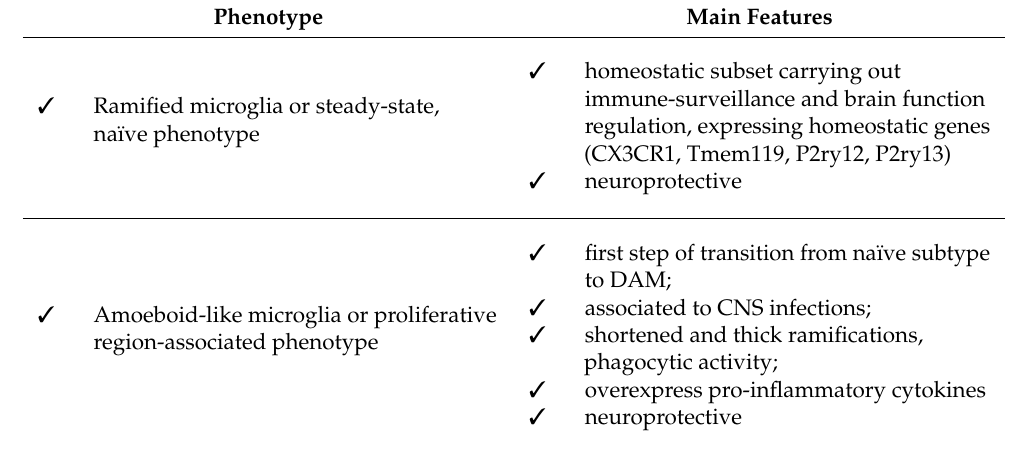
Table 1. Main characteristics of different microglia phenotypes. Changes in microglia phenotypes occur depending on physiological and pathological conditions. CX3CR1: C-X-C motif chemokine ligand 1 receptor; Tmem119: transmembrane protein 119; P2ry12: P2Y receptors 12; P2ry13: P2Y receptors 13; DAM: Disease-associated Microglia; CNS: Central nervous System; TREM2: triggering receptor expressed in myeloid cells 2; TNF α : tumour necrosis factor α ; iNOS: inducible nitric oxide synthase; CCL3: C-C motif ligand 3; CCL4: C-C motif ligand 4; CXCL16: C-X-C motif chemokine